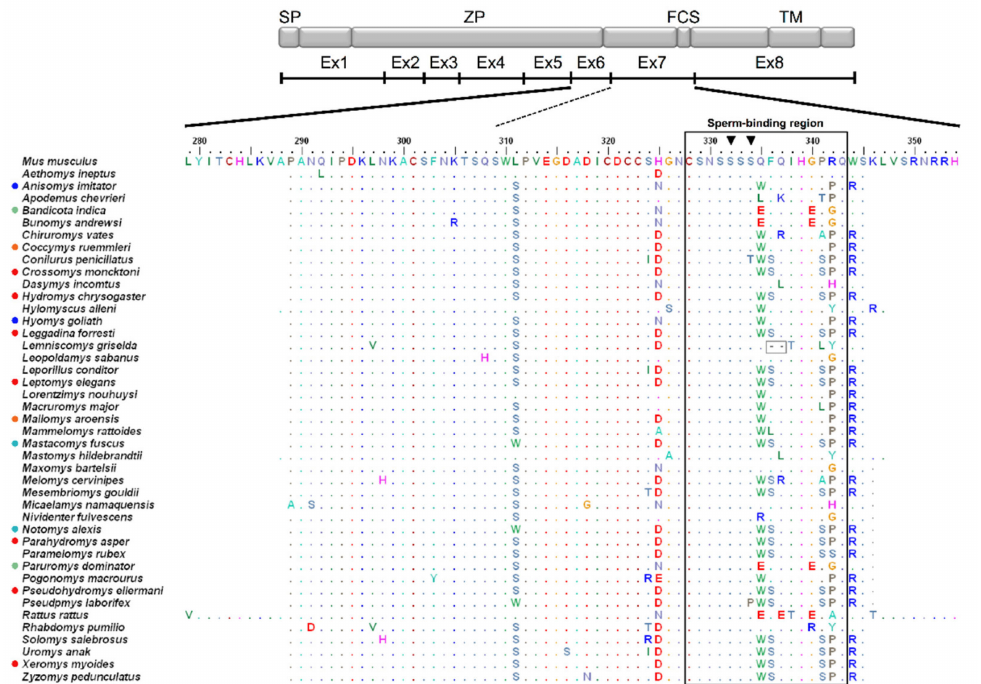
Figure 1. ZP3 (zona pellucida glycoprotein 3) exons 6 and 7 amino acid sequence alignment of Murinae, with a schematic representation of the mouse protein and respective functional domains. Dots represent amino acids identical to the reference Mus musculus sequence and colored circles before species names denote shared haplotypes. The black outlined rectangle delimits the putative sperm-binding region according to [15]. Grey outlined squares highlight deletions relative to M. musculus . Black inverted triangles indicate glycosylation sites S-332 and S-334. SP = signal peptide, ZP = zona domain, FCS = furin cleavage site, TM = transmembrane domain. Ex1-Ex8: exons 1 to